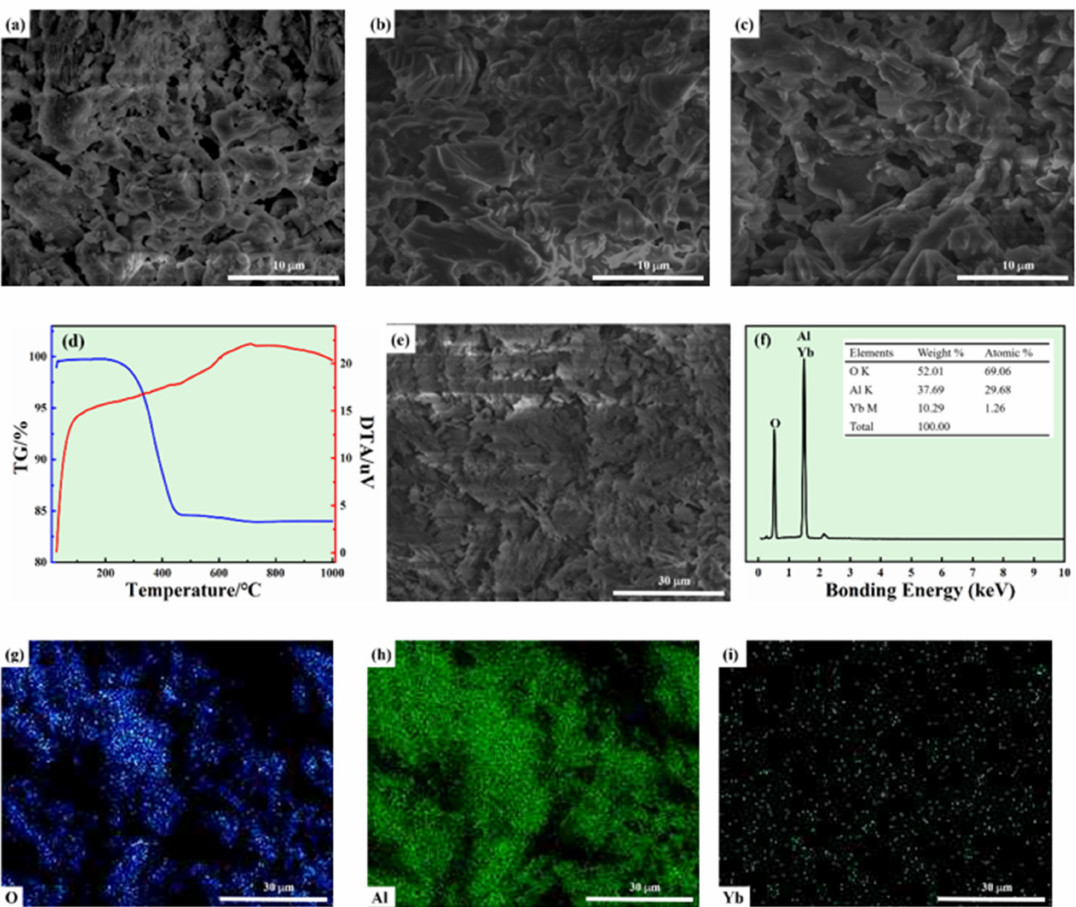
Figure 5. ( a – c ) The surface SEM images of porous Al 2 O 3 ceramic membrane tubes at different temperatures; ( d ) thermogravimetric and differential analyses of green sample; ( d – i ) elemental distribution of porous Al 2 O 3 ceramic membrane tubes prepared at different temperatures: ( a ) 1100 ◦ C; ( b ) 1150 ◦ C; ( c ) 1200 ◦ C; and ( e – i ) 1200 ◦